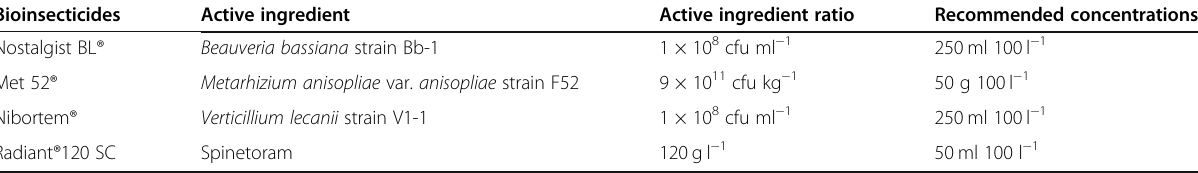
Table 1 Contents and recommended concentrations of the commercial bioinsecticides used in the experiment